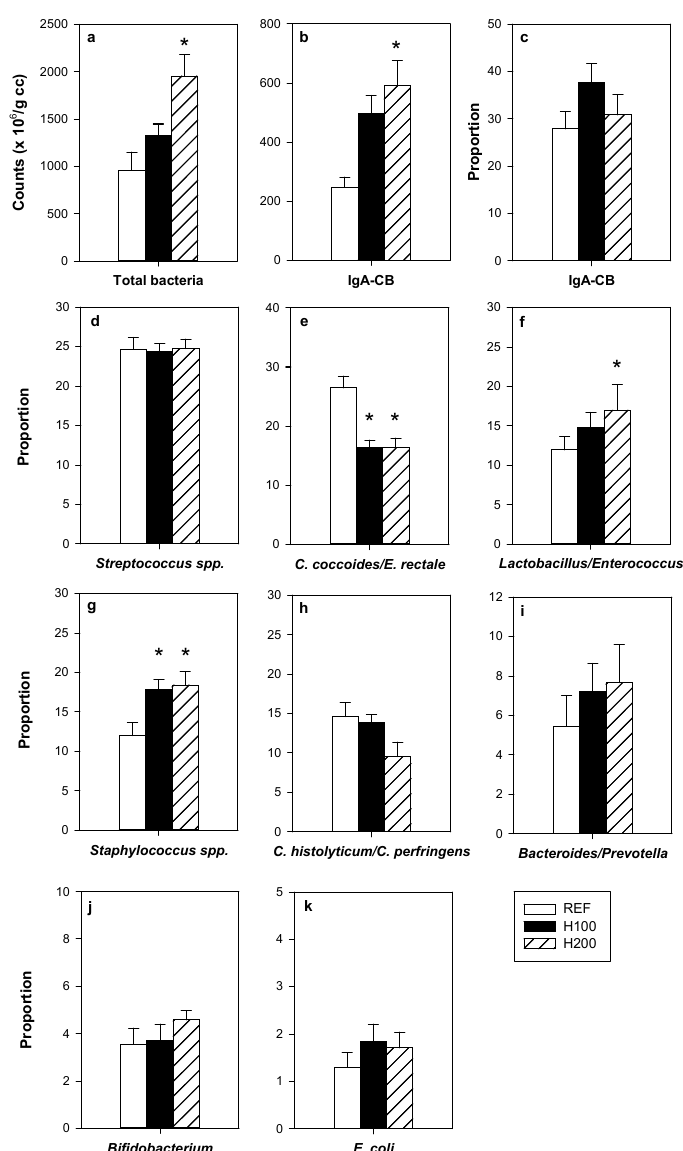
Figure 2. Effect of hesperidin administration on bacterial groups determined by FISH-FCM in caecal homogenates. ( a ) Counts of total bacteria; ( b ) counts of IgA-coated bacteria; ( c ) proportion of IgA-coated bacteria; proportions of ( d ) Streptococcus spp.; ( e ) Clostridium coccoides/Eubacterium rectale ; ( f ) Lactobacillus/Enterococcus ; ( g ) Sstaphylococcus spp.; ( h ) Clostridium histolyticum/Clostridium perfringens ; ( i ) Bacteroides/Prevotella ; ( j ) Bifidobacterium ; and ( k ) Escherichia coli . Data are expressed as mean ± standard error ( n = 5–6). Statistical difference: * p < 0.05 versus REF group (one-way